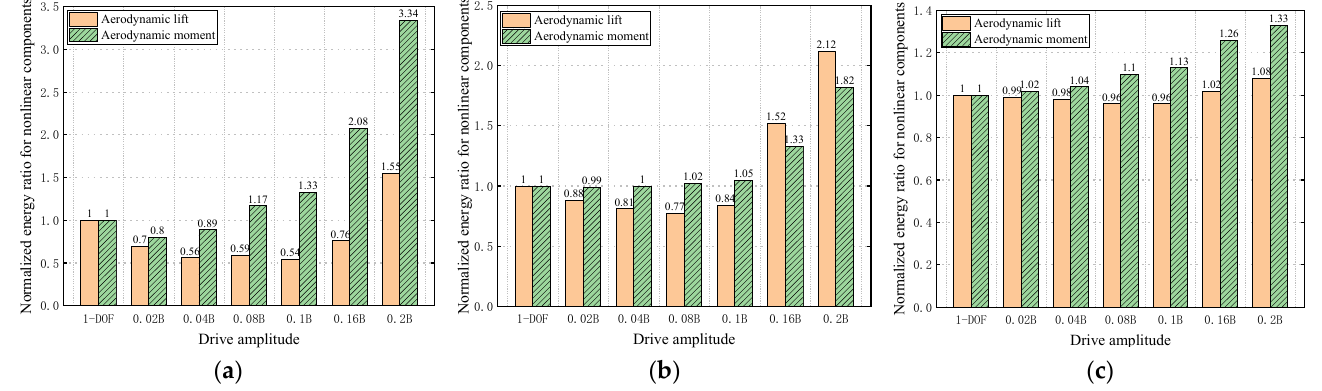
Figure 22. Normalized statistical diagram of aerodynamic nonlinear components in different heaving amplitude. ( a ) foundational pitching amplitude α 0 = 2°; ( b ) foundational pitching amplitude α 0 = 8°; ( c ) foundational pitching amplitude α 0 = 16°.